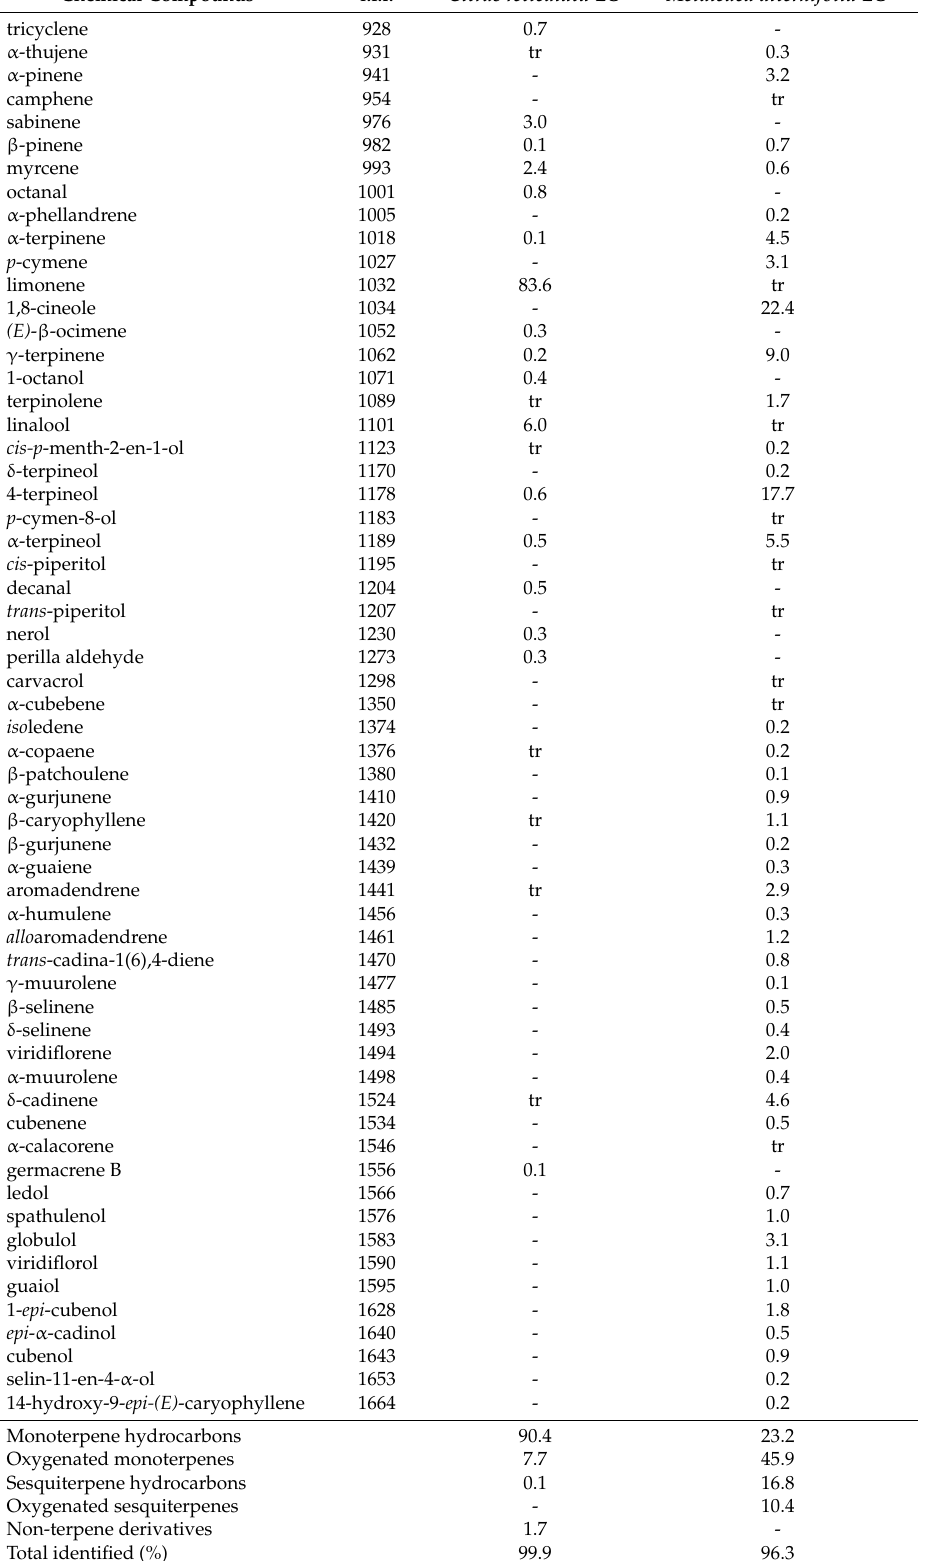
Table 2. Chemical composition of Citrus reticulata and Melaleuca alternifolia essential oils (EOs). LRI: linear retention indices on a DB-5 capillary column; -: not detected; tr: traces, < 0.1%. Chemical